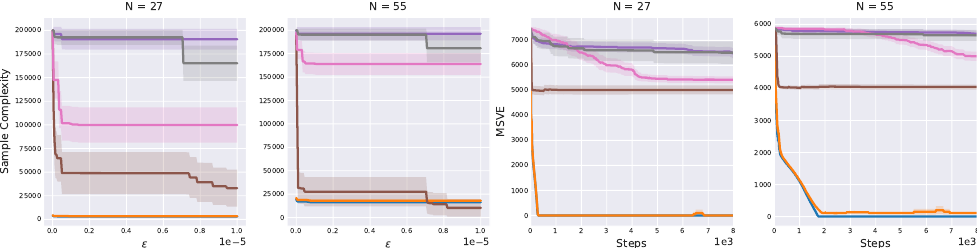
Figure 25. Sample complexity on varying the chain size N = 5,7, . . . ,59. Error bars denote 95% confidence interval. Only the proposed algorithms (blue and orange lines almost overlap) show little sensitivity to ε , as their sample complexity only slightly increases as ε decreases. By contrast, other algorithms are highly influenced by ε . Their estimate complexity has a large confidence interval, and for smaller ε they rarely learn an ε -optimal policy.